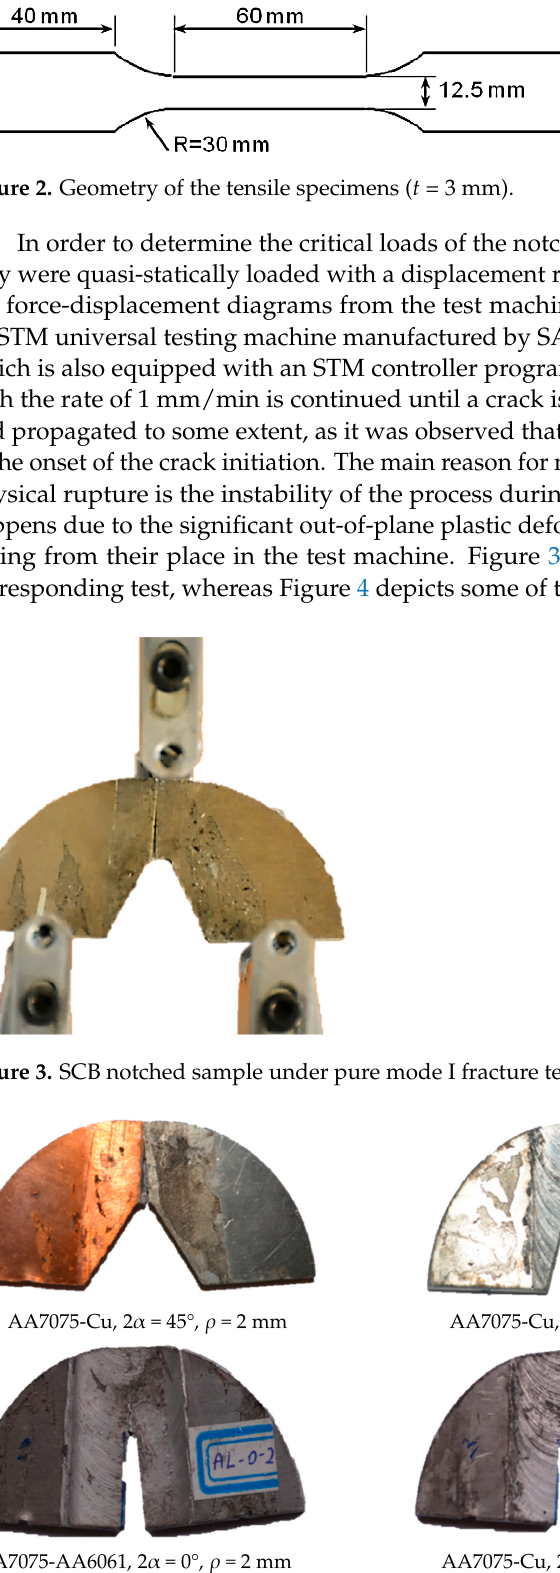
Figure 2. Geometry of the tensile specimens ( t = 3 mm).